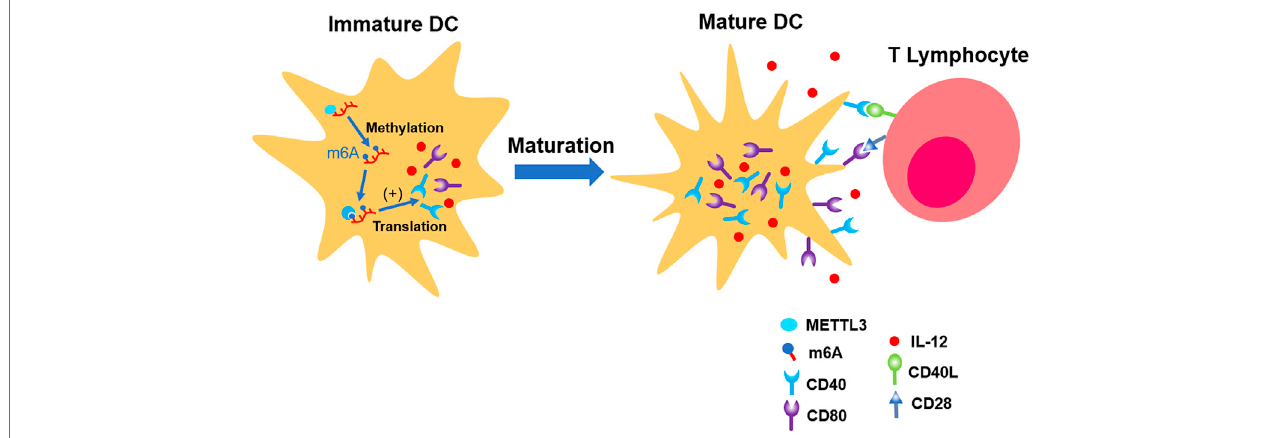
FIGURE 4 | METTL3 up-regulates the expression of CD40, CD80, and IL-12, which promote the maturation of immature DC. In the end, its ability of presenting antigen and interaction with T lymphocytes are strengthened.